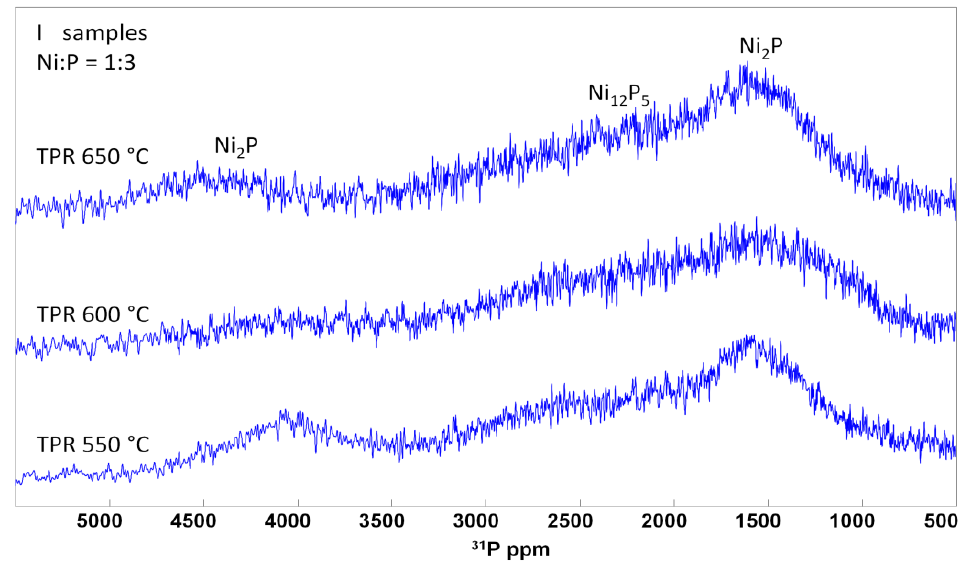
Figure 8. 14 kHz MAS 31 P NMR spectra of NiP_I/Al 2 O 3 samples reduced at 550, 600 and 650 °C. The region with PO x groups is not shown.